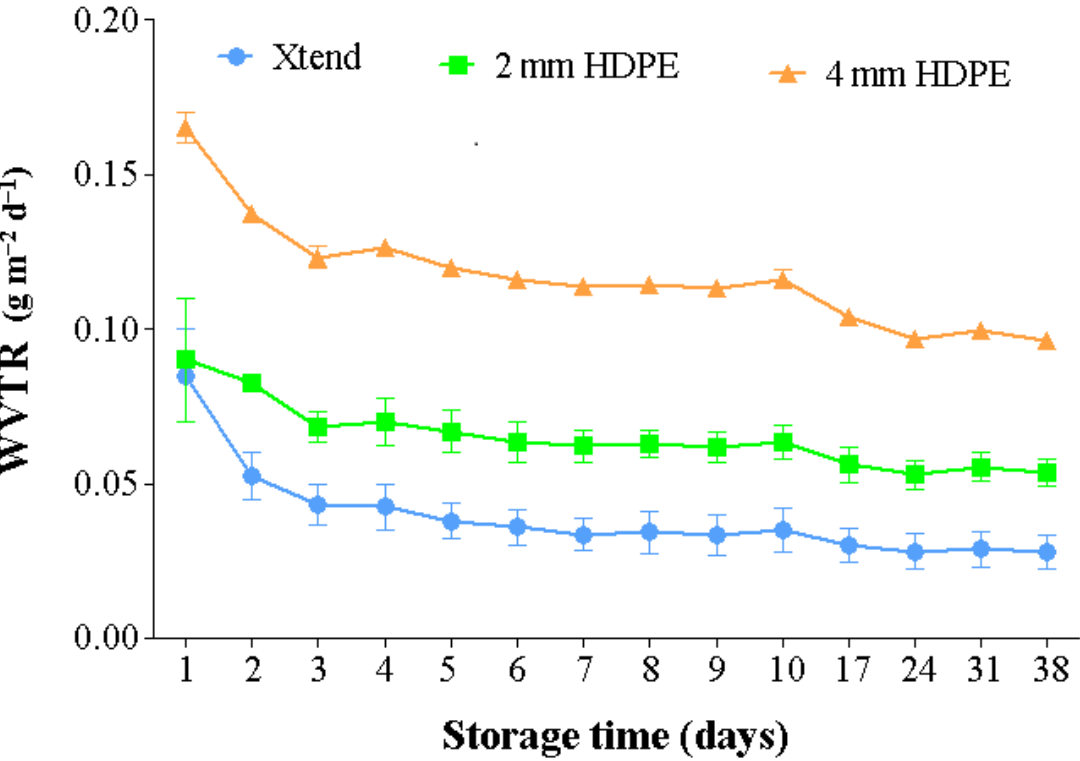
Figure 4. Effect of perforation on water vapor transmission rate (WVTR) under a controlled environment of 20 °C and 90% relative humidity (RH). HDPE: high density polyethylene.